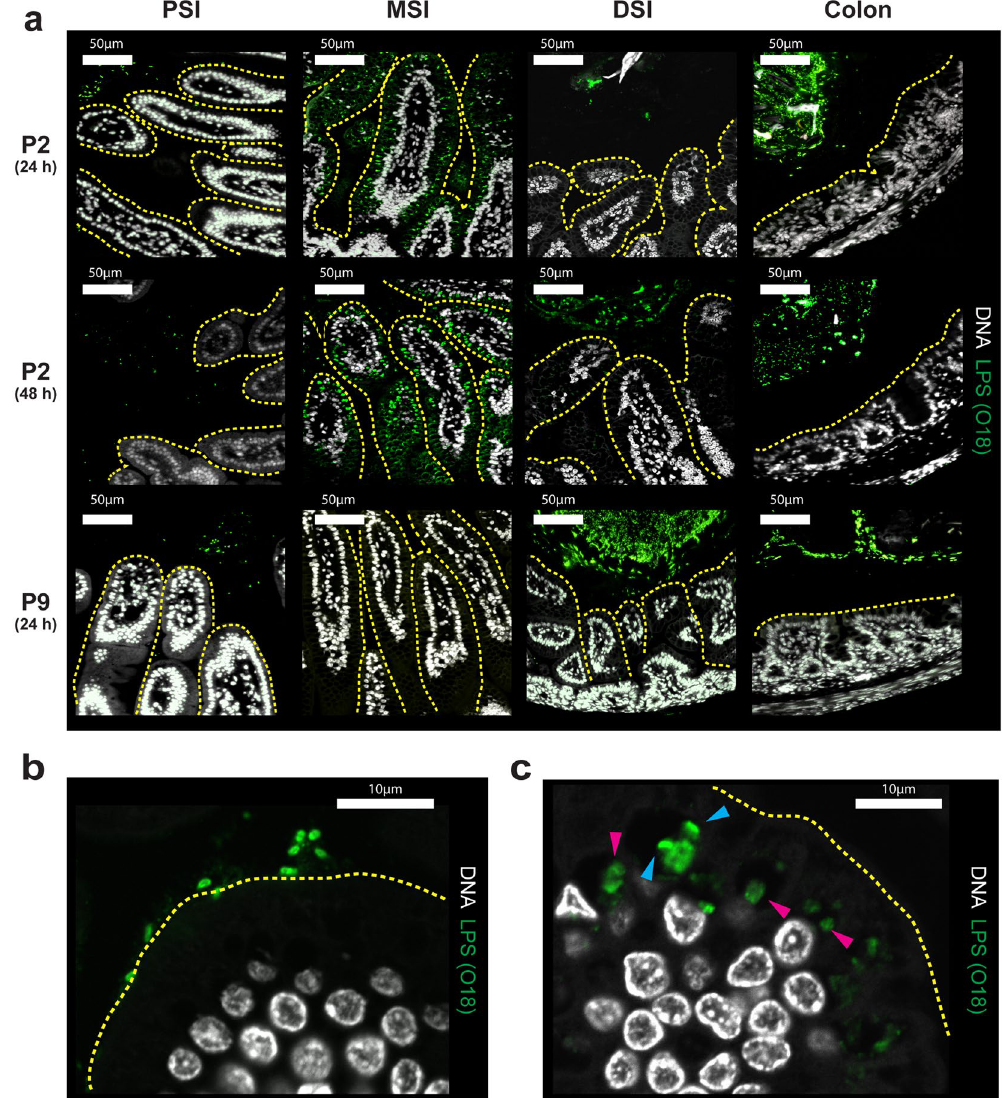
Figure 3. E. coli K1 bacteria colonize and invade the MSI of susceptible P2 rat pups. ( a ) Confocal micrographs of Methacarn-fixed PSI, MSI, DSI and colonic tissue sections from neonates 24 and 48 h (as indicated) after oral dosing of E. coli A192PP at P2 or P9; sections stained for O18 LPS (green) and DNA (grey); epithelial surface indicated by yellow dashed line. Images are representative of the various regions of the GI tract of at least three colonized pups. ( b , c ) Confocal micrographs of MSI tissue from neonatal rats 24 h after oral dosing with E. coli K1 at P2; intracellular LPS staining with bacterial cellular morphology ( ) or a more diffuse appearance ( )